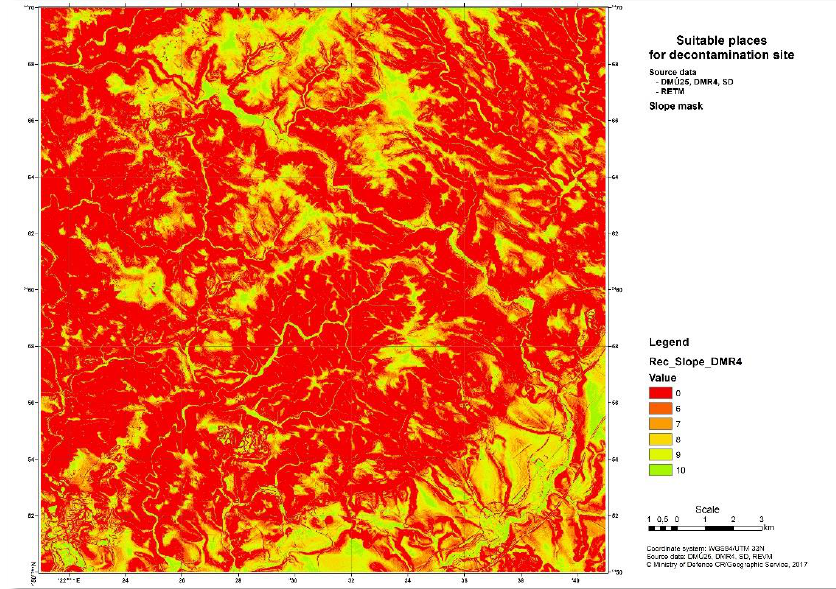
Figure 2. Raster file of reclassified slope inclinations.